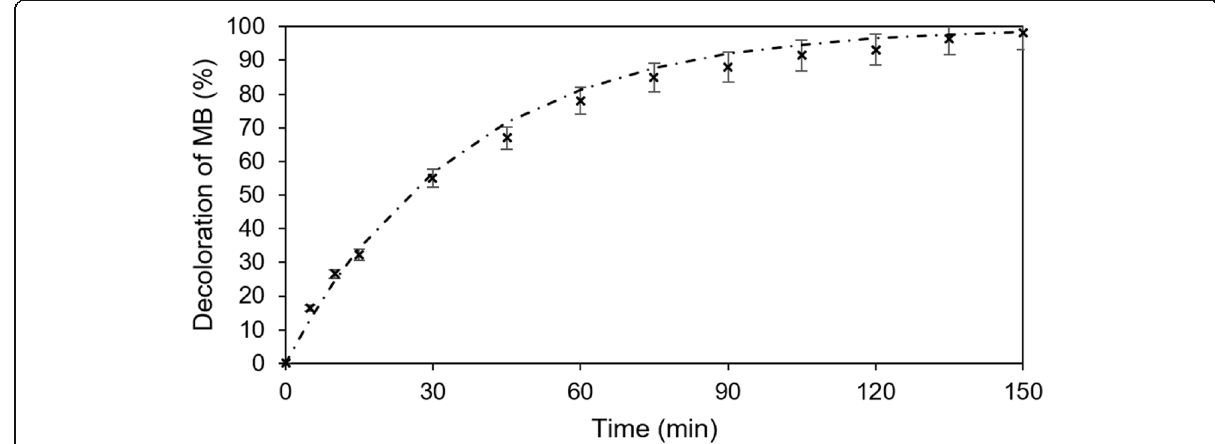
Fig. 9 Experimental (symbols) and modelled data (dotted line) for MB degradation using Nb 2 O 5 /Al 2 O 3 /Al catalyst under optimal operating conditions